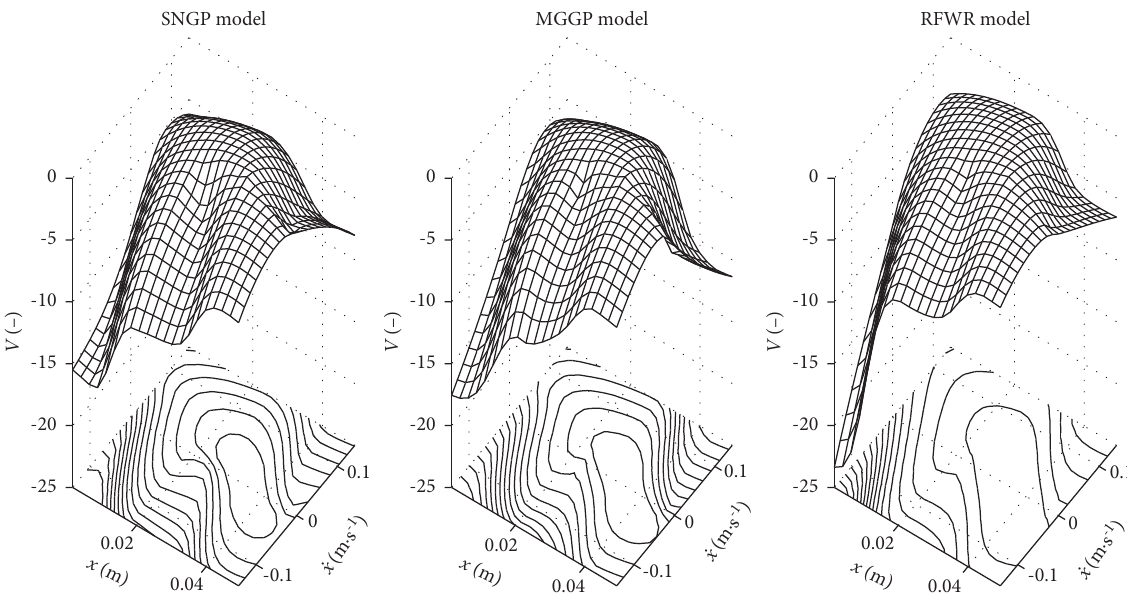
Figure 6: Comparison of V -functions based on the best fitting models from each of the approximation methods: SNGP, MGGP, and